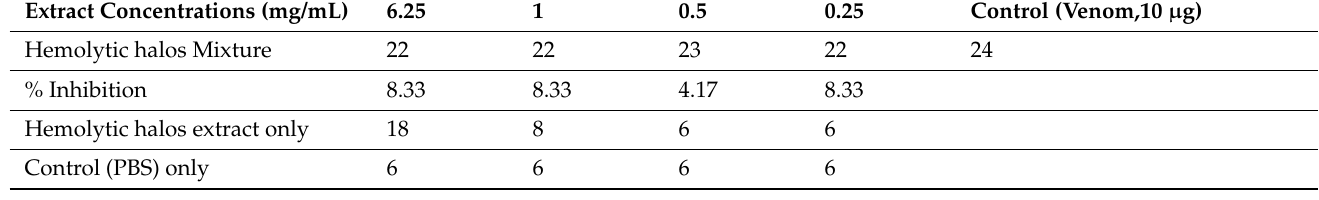
Table 9. Neutralization of PLA 2 hemolytic activities of venom by aqueous extract.